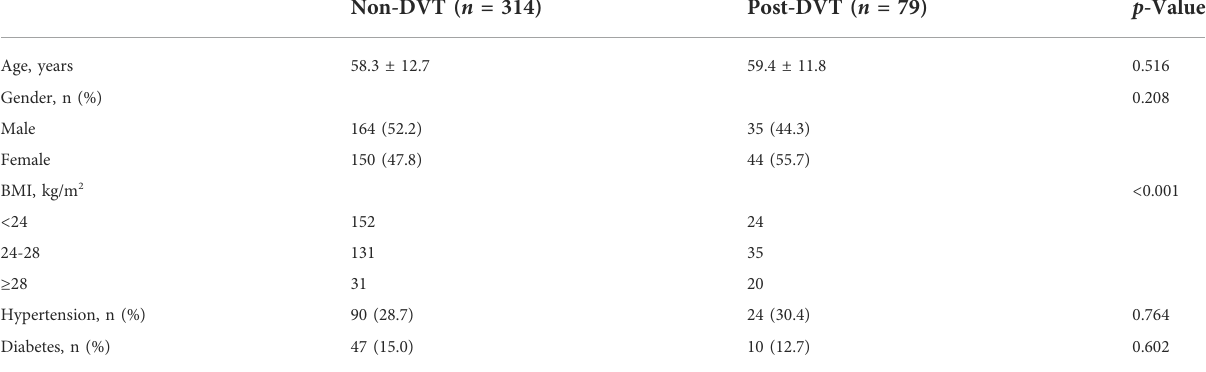
TABLE 1 Demographic data of